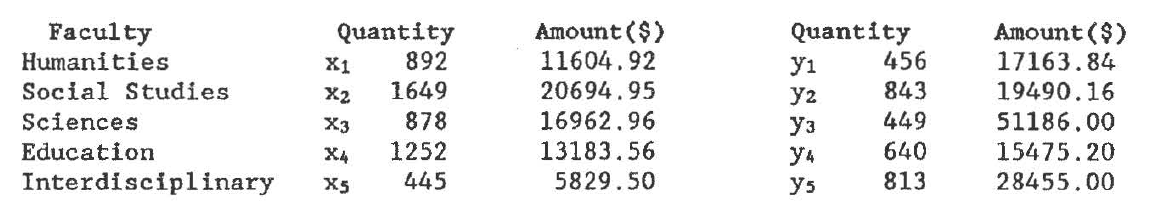
Table 2 : Phase One Allocation to